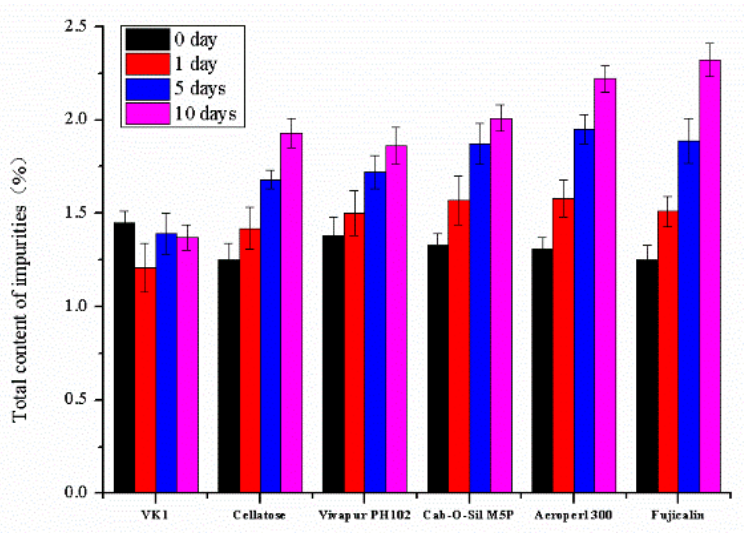
Figure 8. Total content of impurities after incubation at 60 °C/92% RH away from light for 1, 5, or 10 days for drug-excipient chemical compatibility study.